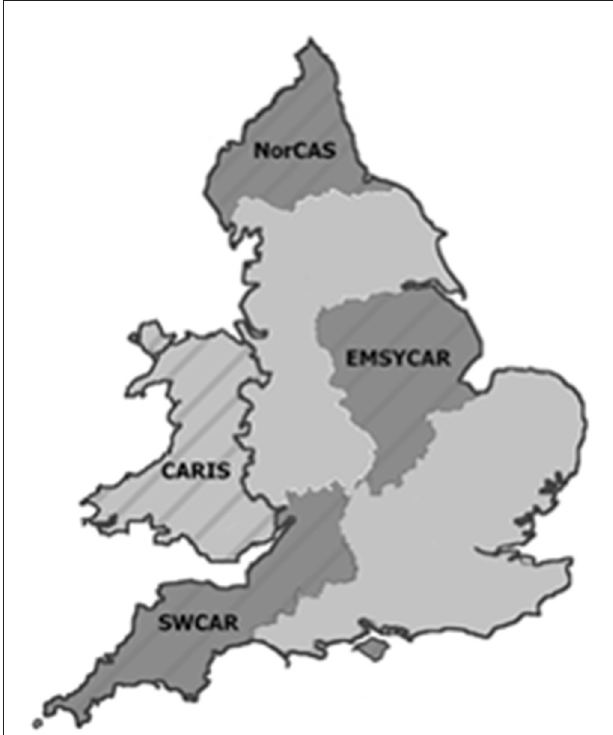
FIGURE 1 | Map showing the area covered by the congenital anomaly